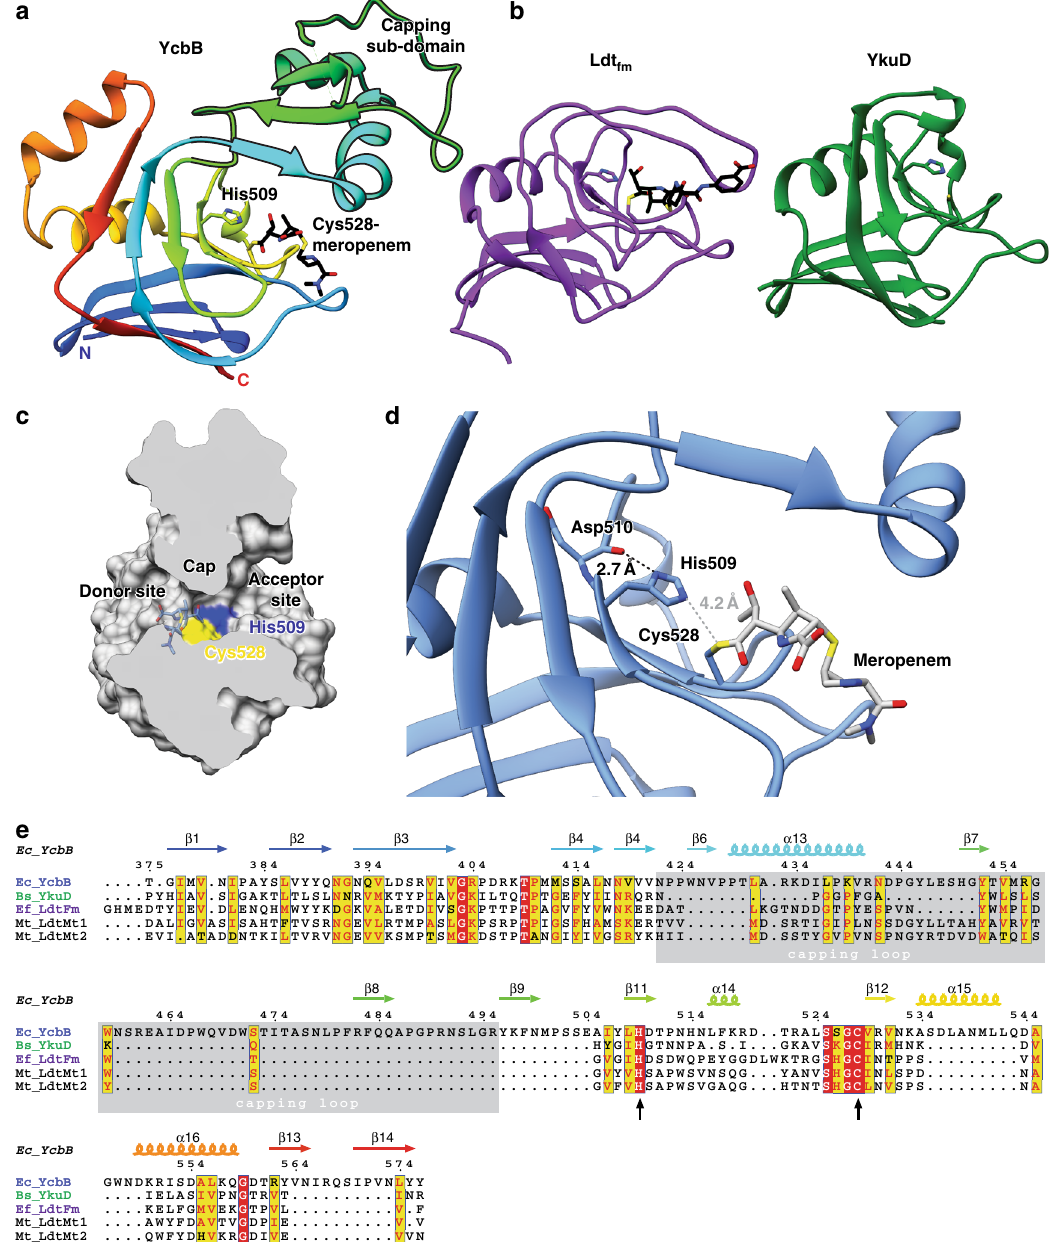
Fig. 3 Structure of the E. coli YcbB catalytic domain. a A ribbon representation of the YcbB catalytic domain, residues 375 – 576, coloured in rainbow from red (N-terminus) to blue (C-terminus). Meropenem is represented in black and coloured by heteroatom. The unique capping sub-domain is highlighted in a bold silhouette. b The catalytic domain architecture of Enterococcus faecium Ldt Fm (PDB ID 3ZGP 17 ) and Bacillus subtilis YkuD (PDB ID 1Y7M 13 ) highlighting the differences seen among L,D-transpeptidase catalytic domains in the capping loop region. c Cut surface representation of the YcbB catalytic domain, showing the capped cleft formed between the donor and acceptor sites by the capping loop sub-domain. The catalytic Cys528 and His509 are coloured in yellow and blue respectively. Meropenem (blue) is overlaid in its position in the donor site, acylating the catalytic cysteine. d The active site architecture of E. coli YcbB. The catalytic Cys528 is acylated by meropenem and the sulphide is rotated away from the N τ of His509 (4.2 Å) which activated the cystine prior to acylation. The N π of His509 is seen to be in close proximity with the backbone carbonyl of the adjacent Asp510 (2.7 Å), stabilising and promoting formation of the histidine cation. e The sequence of E. coli YcbB (Ec_YcbB) aligned with the aforementioned catalytic domains from E. faecium and B. subtilis (Ef_Ldtfm and Bs_Yku, respectively) as well as Ldt Mt1 and Ldt Mt2 from Mycobacterium tuberculosis (Mt_LdtMt1 and Mt_LdtMt2,